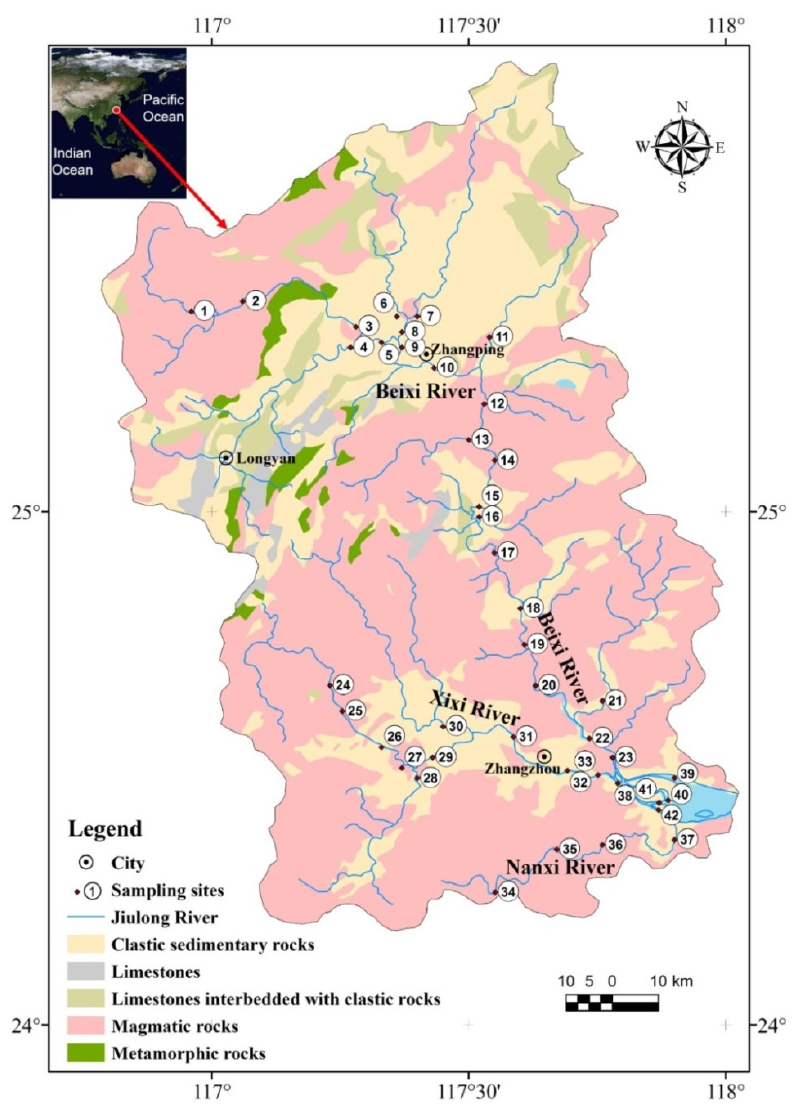
Figure 1. Sample sites’ distribution and lithology for JRB.2.2. Sampling and Chemical Analysis.